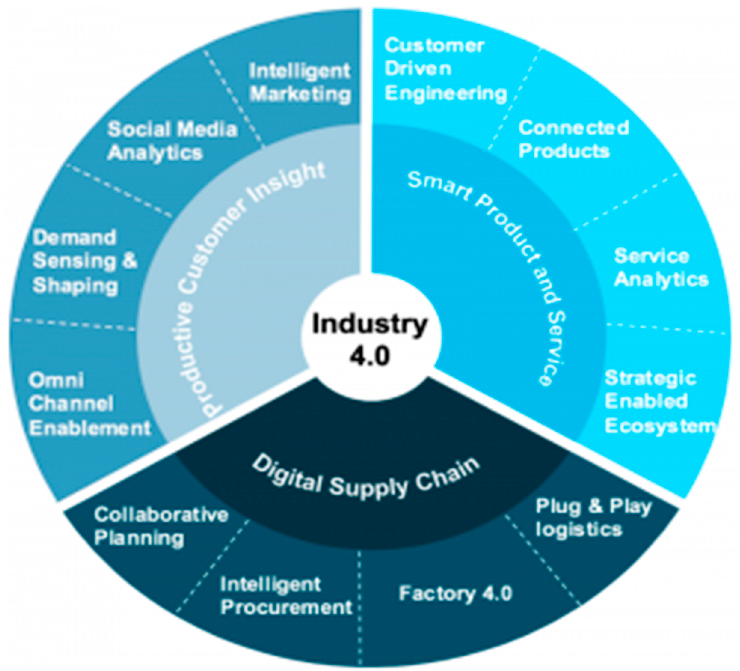
Figure 3. The Concept of the Fourth Industry Revolution. Source: Own contribution of the authors.